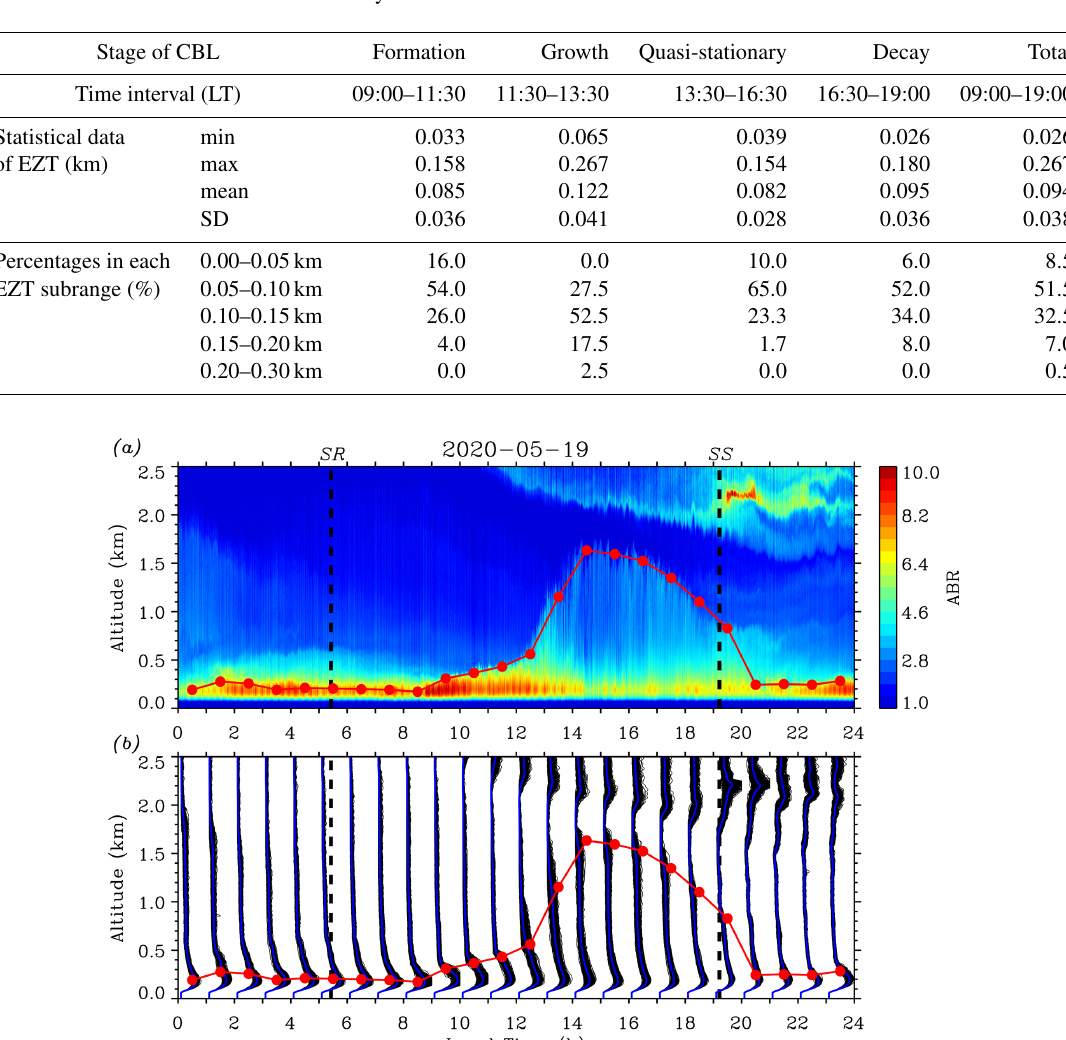
Figure 7. Same as Fig. 4 but on 19 May 2020.